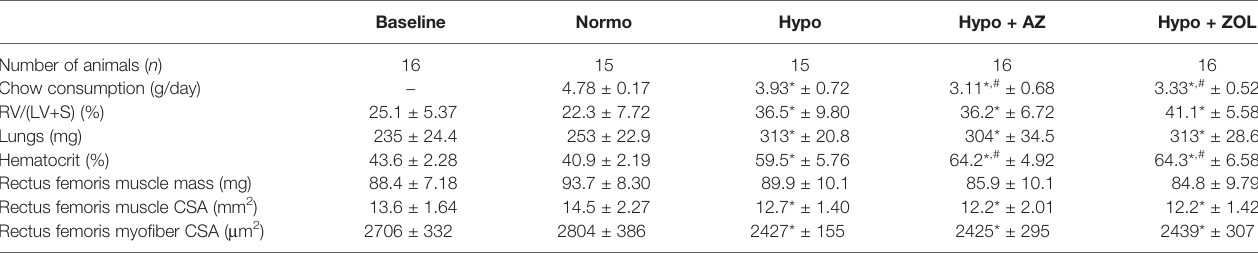
TABLE 1 | Number of animals per group, mean daily chow consumption per mouse, right ventricle to left ventricle and septum [RV/(LV+S)] weight ratio, lungs wet weight, hematocrit, muscle mass, muscle cross-sectional area (CSA), and myo fi ber CSA of mice housed at normobaric ambient pressure (Normo) or hypobaric pressure (Hypo) at 500 mbar for four weeks and treated with acetazolamide (AZ) or zoledronate (ZOL).